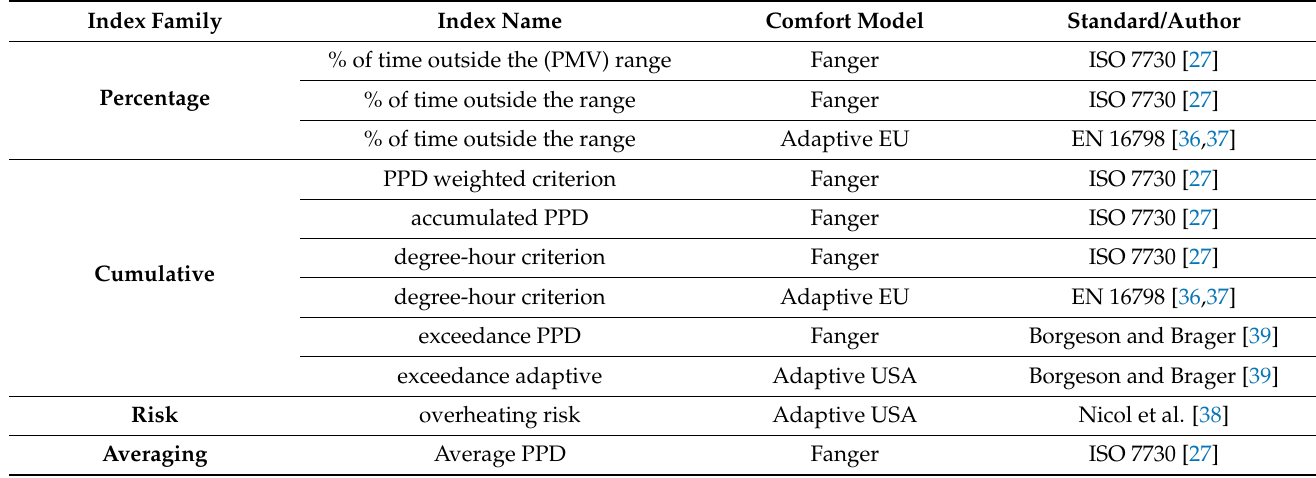
Table 1. Indoor thermal comfort indices summary for the long-term evaluation (adapted from